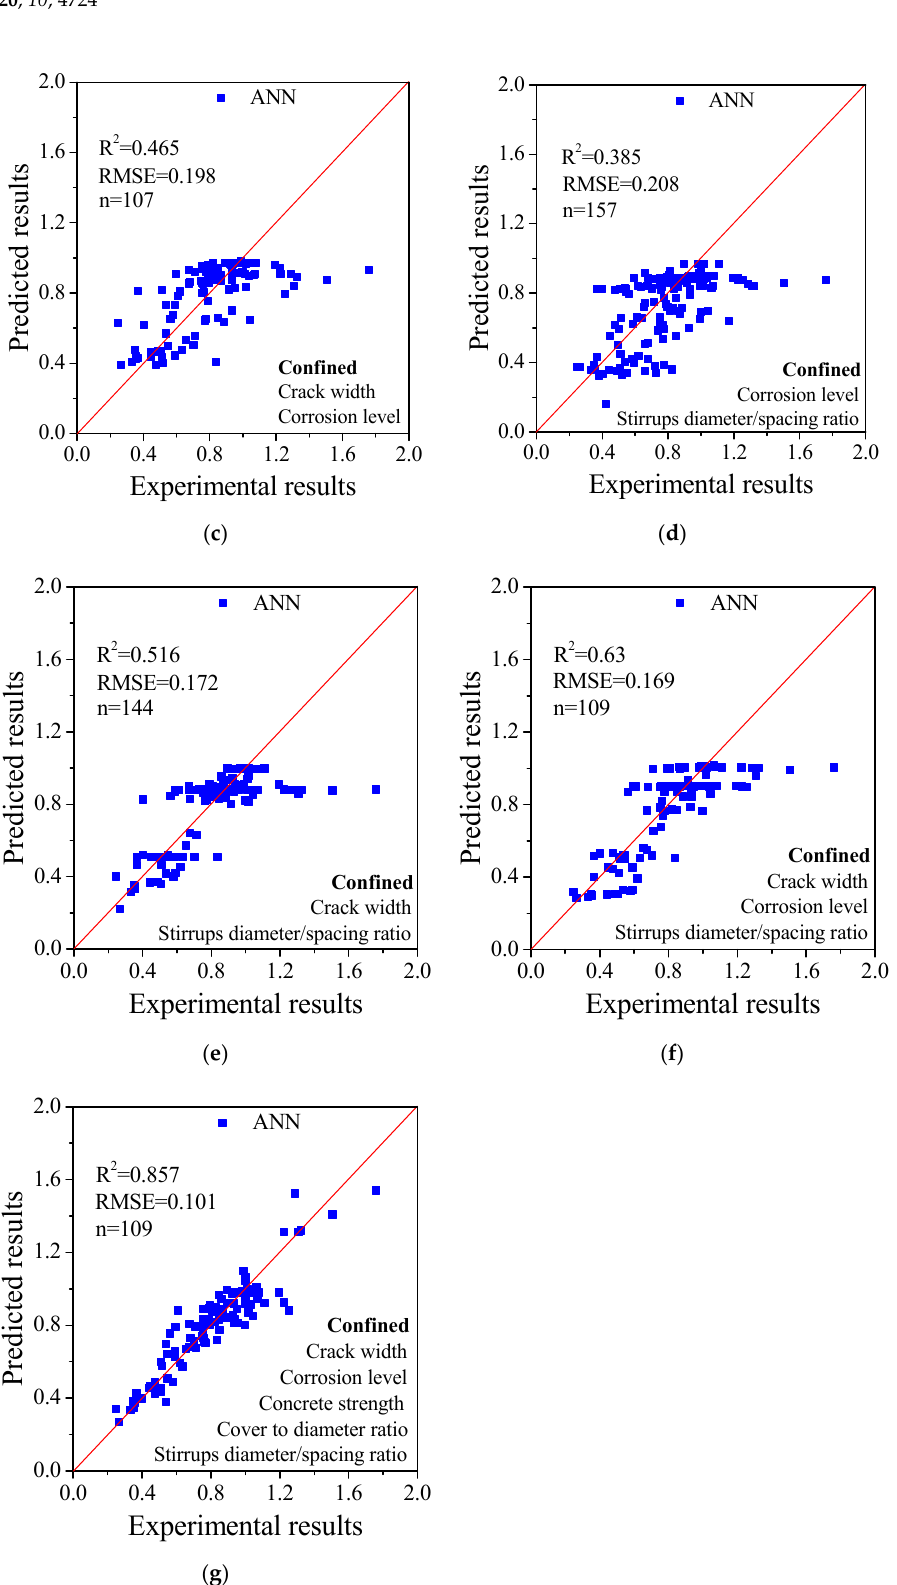
Figure 10. Comparison of the results calculated by ANN method considering di ff erent parameters for the confined cases: ( a ) corrosion level; ( b ) crack width; ( c ) crack width and corrosion level; ( d ) corrosion level and stirrups diameter / spacing ratio; ( e ) crack width and stirrups diameter / spacing ratio; ( f ) crack width, corrosion level and stirrups diameter / spacing ratio; ( g ) crack width, corrosion level, concrete strength, cover to diameter ratio and stirrups diameter / spacing